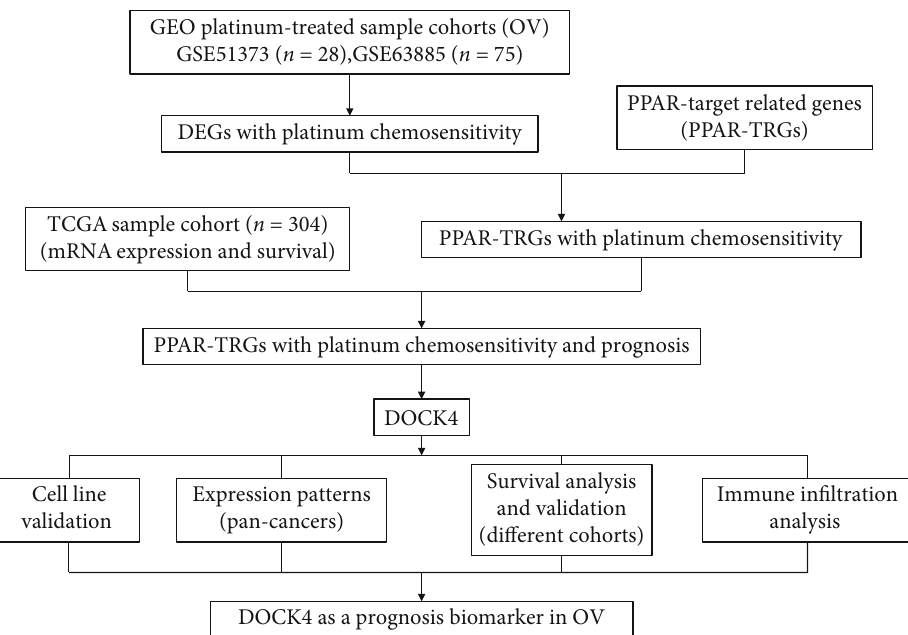
Figure 1: The fl ow chart shows the scheme of our study on mRNA prognostic signatures for OV (ovarian